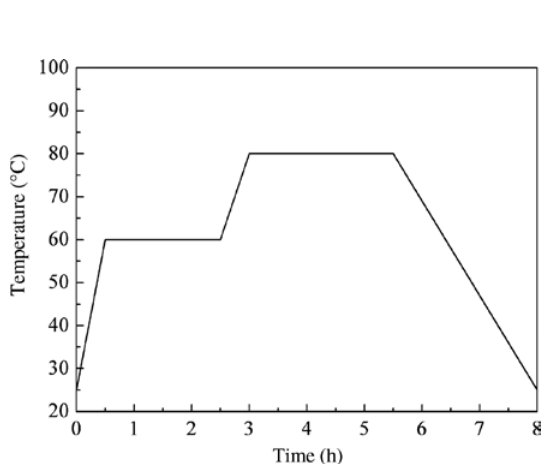
Figure 1: The curing schedule of the GFRP